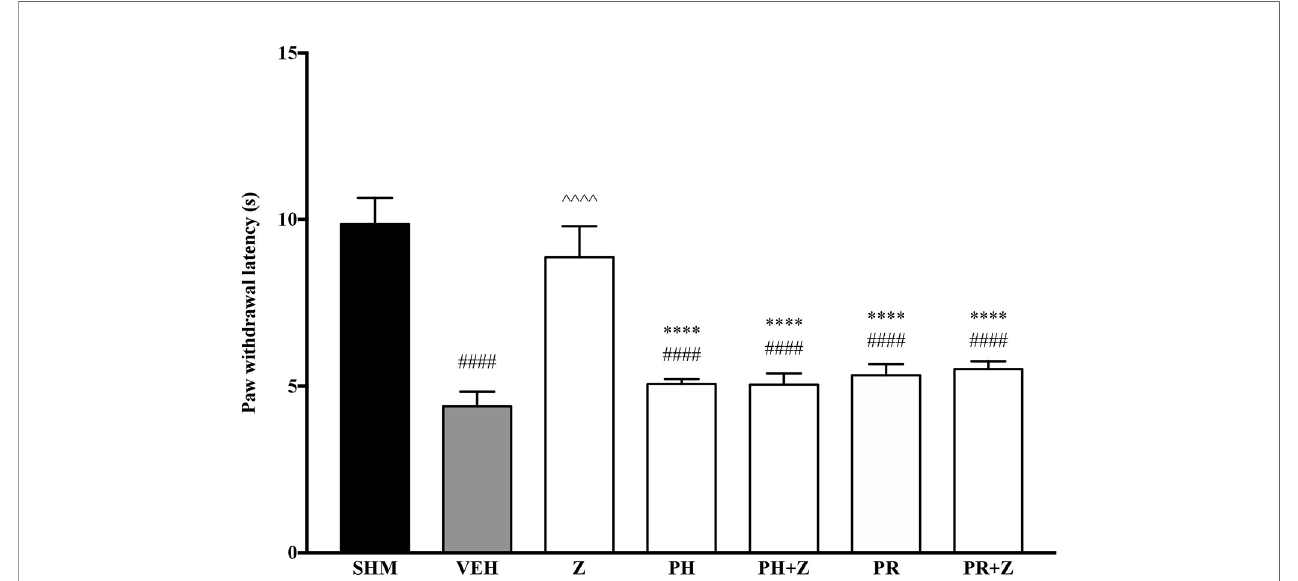
FIGURE 2 | Effect of phentolamine (non-selective a -adrenoceptor antagonist) and propranolol (non-selective b -adrenoceptor antagonist) pre-treatment on zerumbone against thermal hyperalgesia in CCI-induced neuropathic pain mice. Data are presented as mean ± SEM (n = 6) #### p < 0.0001 as compared to sham, ^^^^ p < 0.0001 as compared to vehicle and *****p < 0.0001 as compared to zerumbone-treated group. SHM (Sham); VEH (Vehicle, 10 ml/kg i.p.); Z (Zerumbone, 10 mg/kg i.p.); PH (Phentolamine, 5 mg/kg i.p.); PR (Propranolol, 5 mg/kg